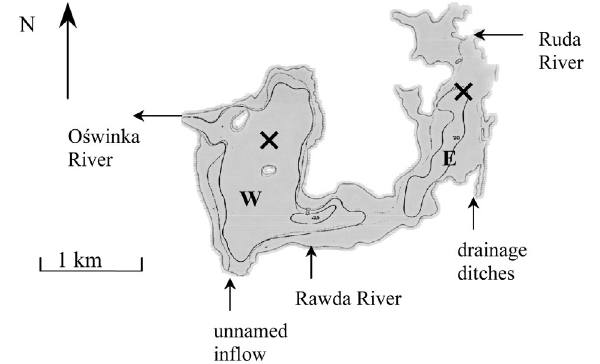
Fig. 1. Location of sampling areas of fish ( X ) in OÊwin Lake; E, eastern-; W, western part of the lake MATERIAL AND